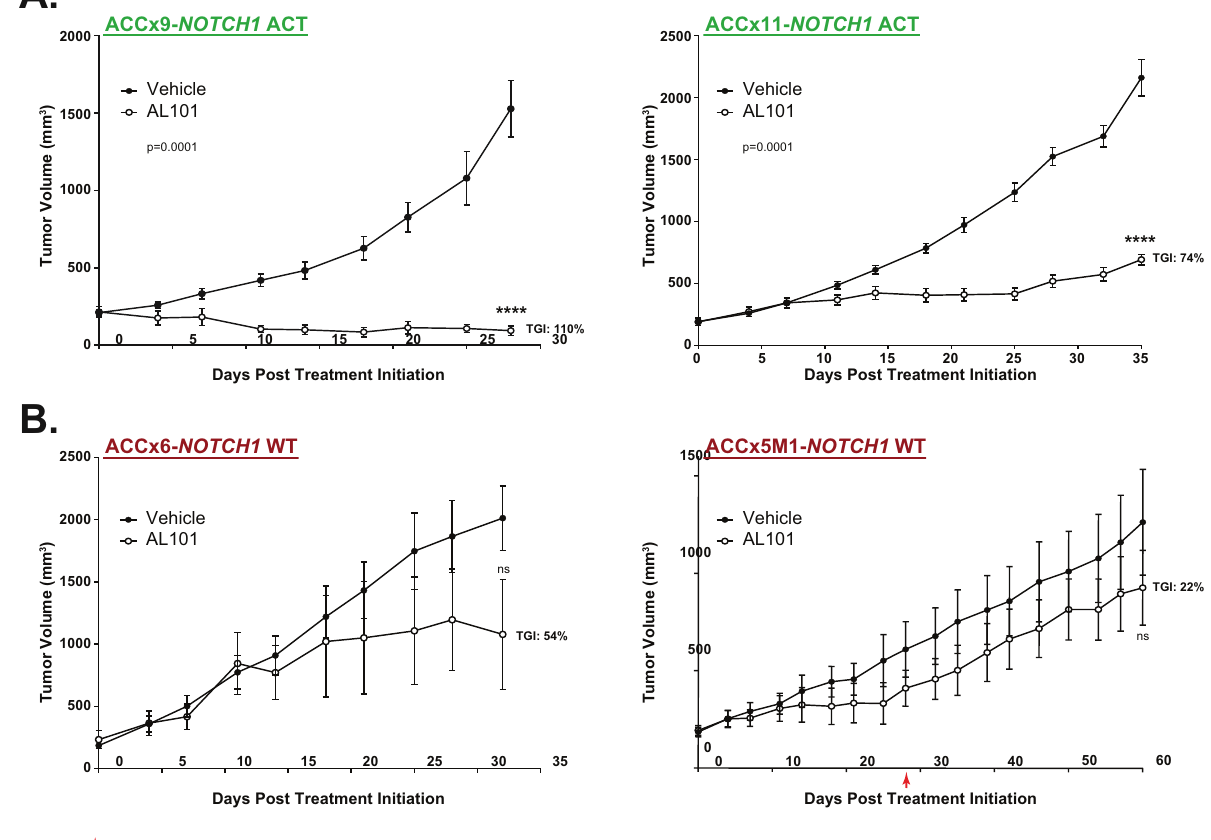
Fig. 3 AL101 induces tumor growth inhibition in NOTCH1-mutated ACC PDX models. Two ACC PDX models harboring tumors with NOTCH1 activating alterations (NOTCH-Act) ( A ) and two PDX models without NOTCH-activating mutations (NOTCH WT) ( B ) were treated with either AL101 or vehicle. Graphs show the average tumor volume for fi ve to ten animals ±SD. Red arrow: dosage reduced on day 28 and administered at 5 mg/kg. ** p < 0.01, **** p < 0.001. Act activated NOTCH1 , WT wild-type NOTCH1